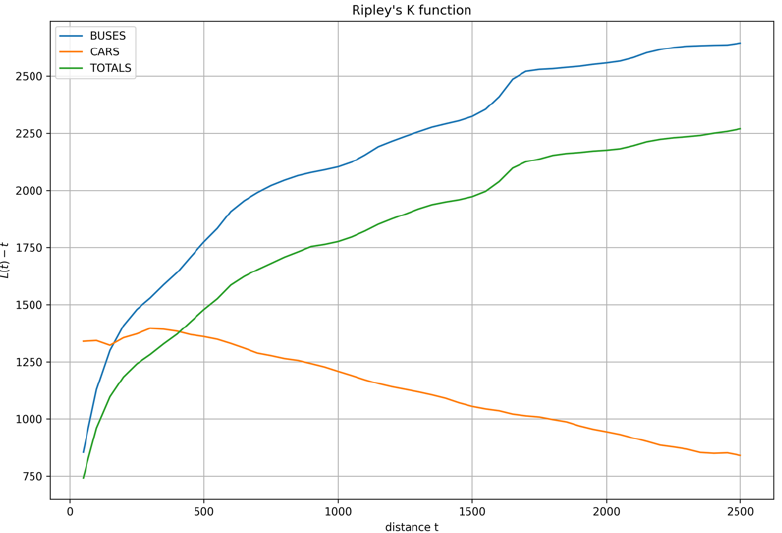
Figure 5. Ripley’s K functions calculated for buses (light blue), cars (orange), and the full dataset (green).